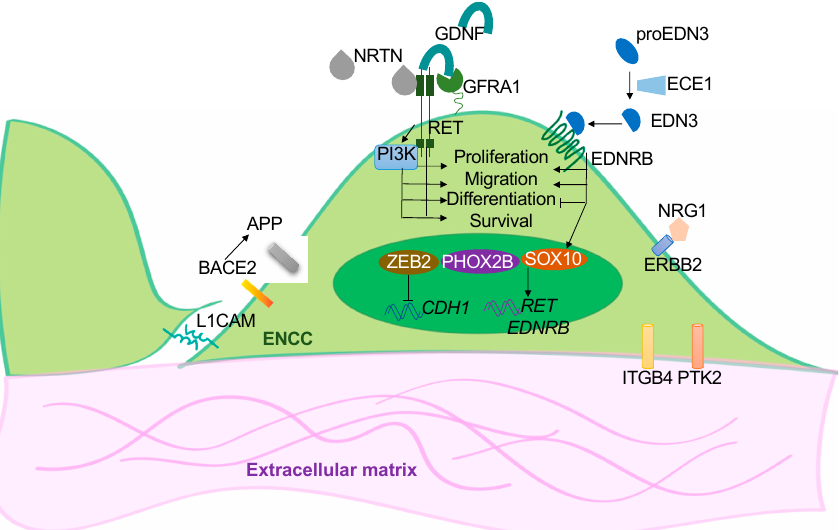
Figure 1. Overview of the functions of the disease genes. Simplified illustration showing the functional roles of the HSCR-associated genes in ENS development. These disease-associated genes encode for the cell surface receptors (RET, EDNRB and ERBB2) in the ENCCs and their ligands (GDNF, NRTN, EDN3, ECE1 and NRG1); the transcriptional factors (SOX10, ZEB2 and PHOX2B); or the cell-cell (L1CAM) and cell-extracellular matrix (IGGB4, PTK2) interacting molecules. BACE2 is a protease that acts on APP to prevent the production of toxic Ab peptides from protecting the survival of ENCCs.